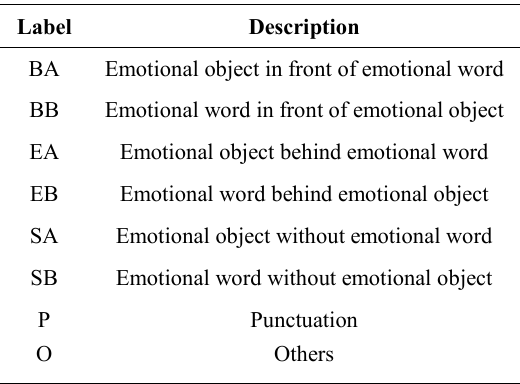
Table 1. Label list for conditional random fields